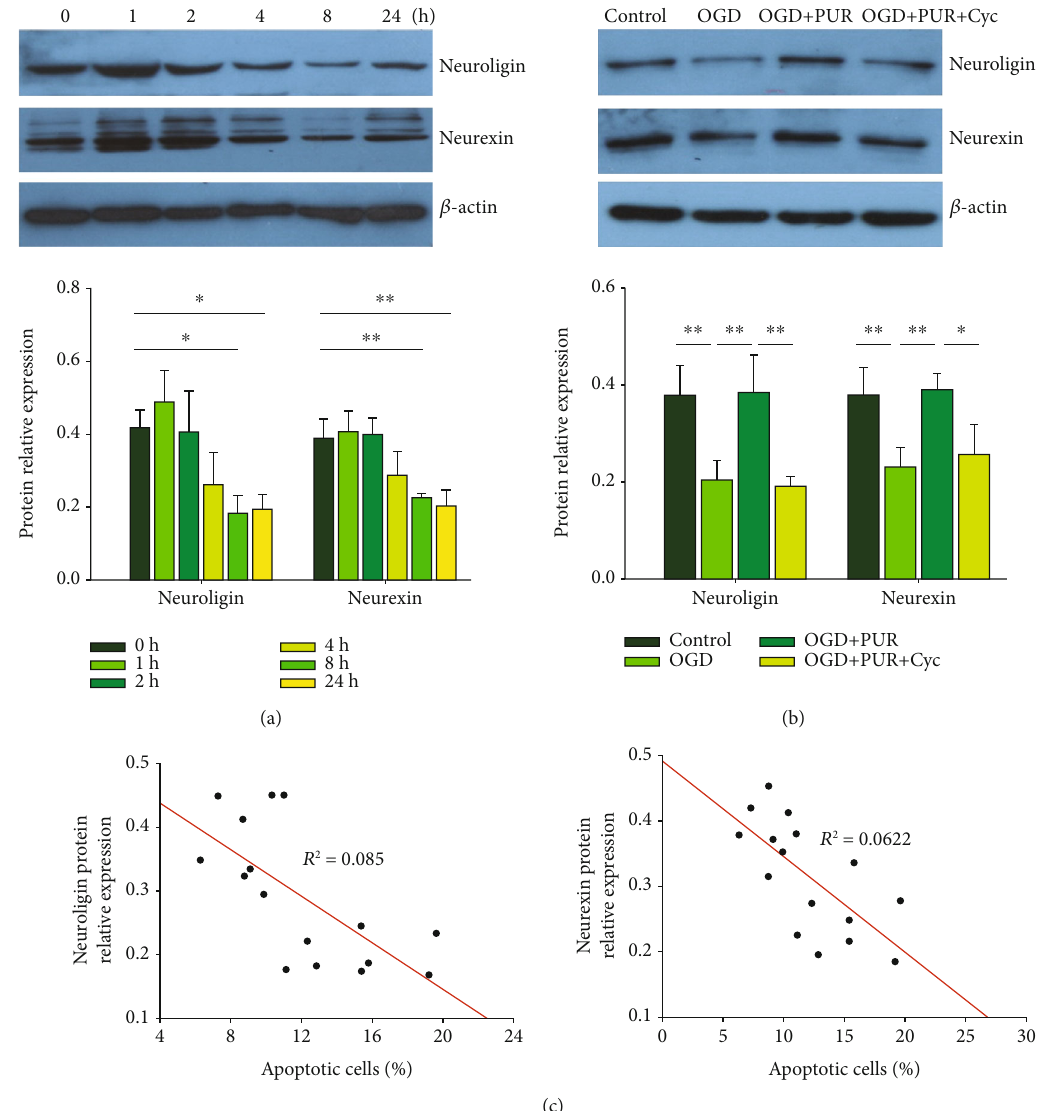
Figure 4: PUR activation of Shh on OGD-induced neuroligin and neurexin: (a) protein levels of neuroligin and neurexin at 1, 2, 4, 8, and 24h after OGD as determined by Western blot ( N = 3 /group); (b) protein levels of neuroligin and neurexin at 24 h after OGD as determined by Western blot ( N = 4 /group); (c) Pearson correlation coe ffi cients obtained between neuroligin/neurexin expressions and apoptosis following PUR treatment. Values represent the mean ± SD ; ∗ p < 0 : 05 and ∗∗ p < 0 : 01 according to ANOVA with the Dunnett test in (a) and Tukey ’ s post hoc comparisons in